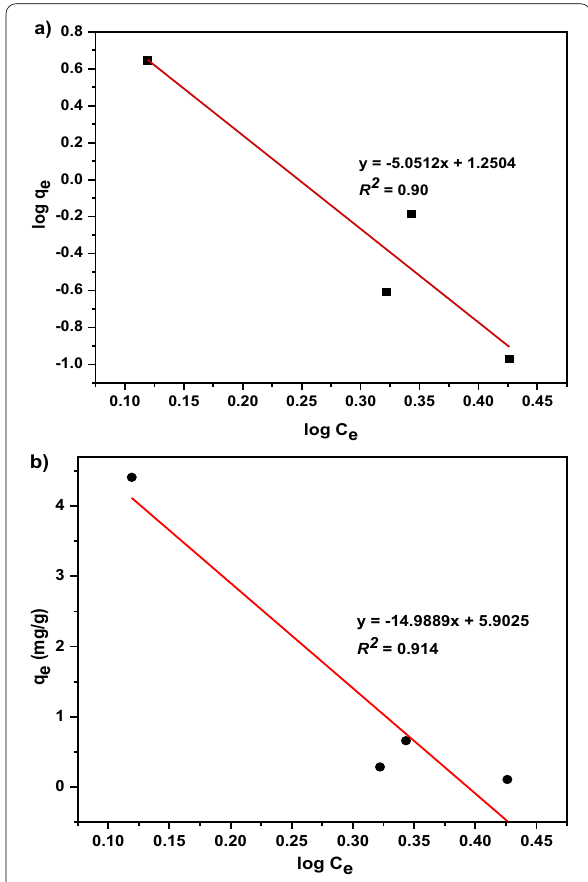
Fig. 15 a Linearized Freundlich; b Linearized Temkin isotherm models for Cu 2 + adsorption by MNA-7 h at various adsorbent dosages: contact time 240 min; initial pH 5.4; room temperature